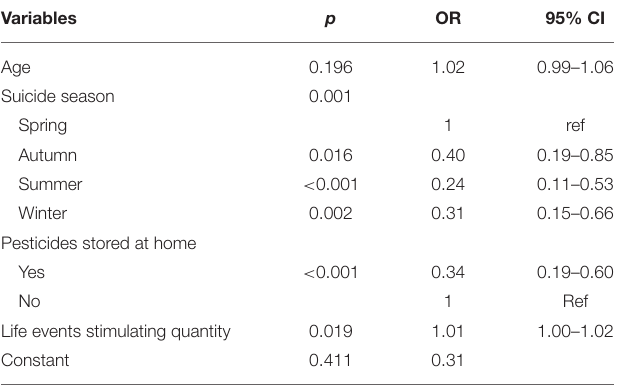
TABLE 4 | Factors related to violent suicide methods: a logistic regression